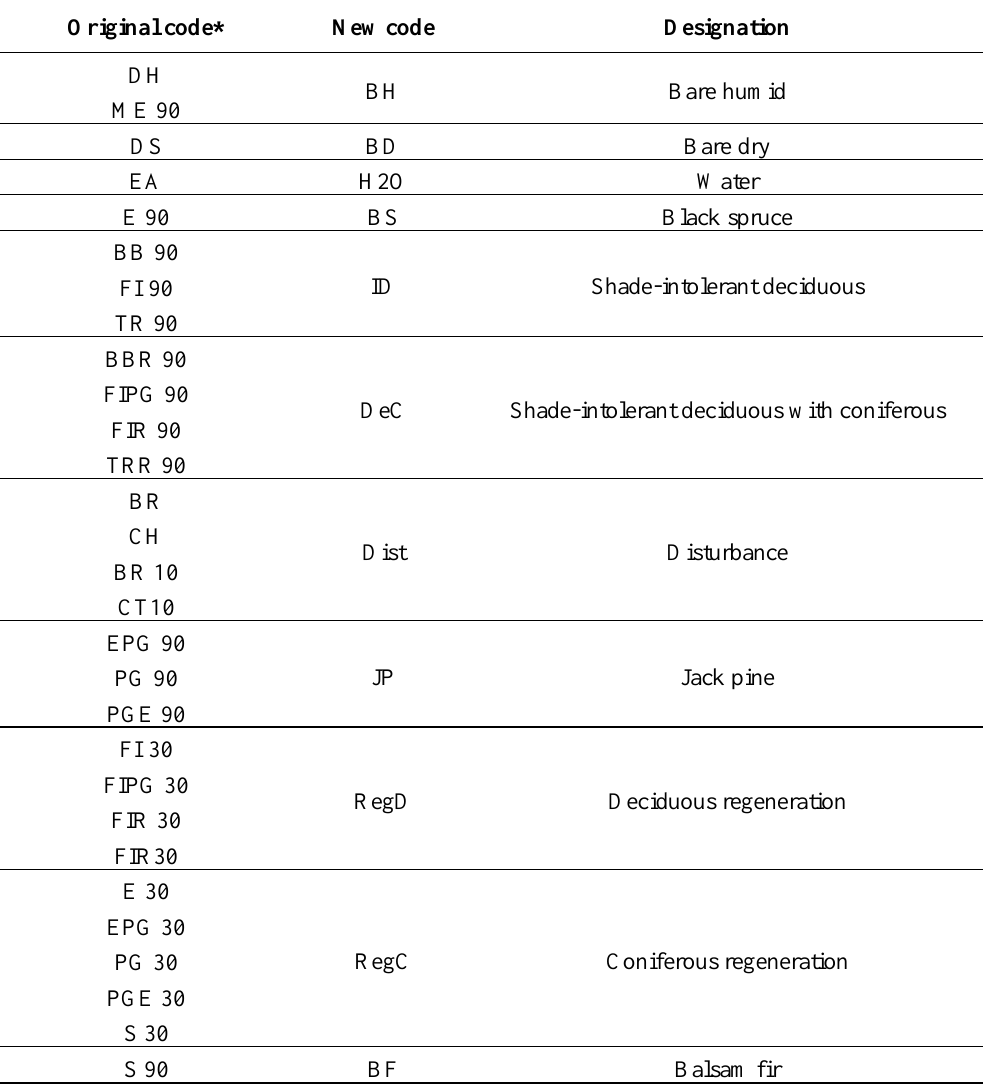
Table A1. Grouping of the vegetation cover types based on